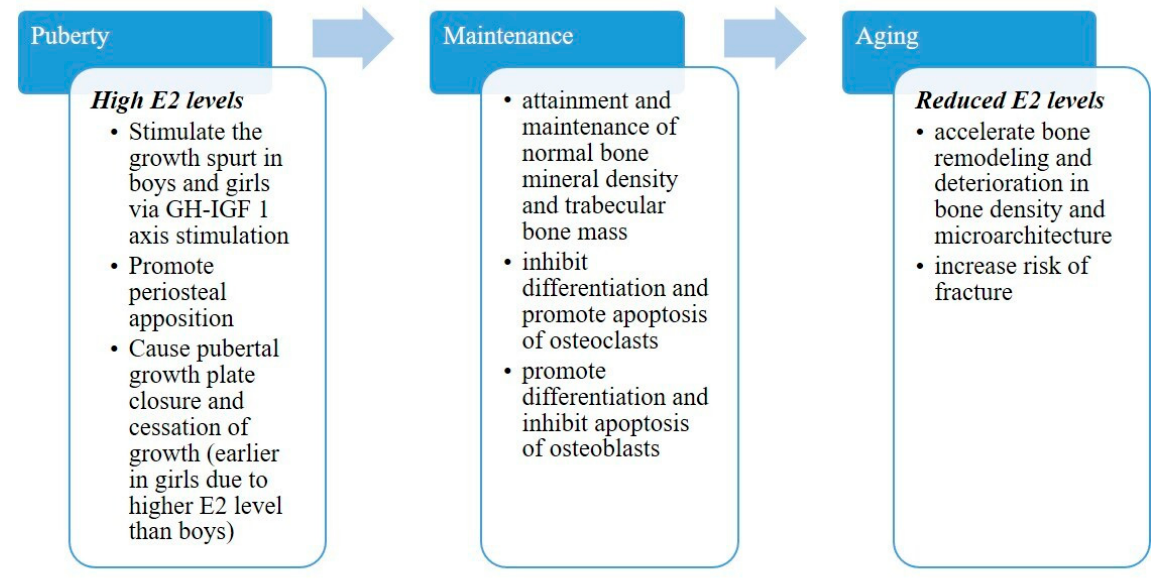
Figure 1. Roles of estrogen in women and men throughout life. (E2: 17 β -estradiol).